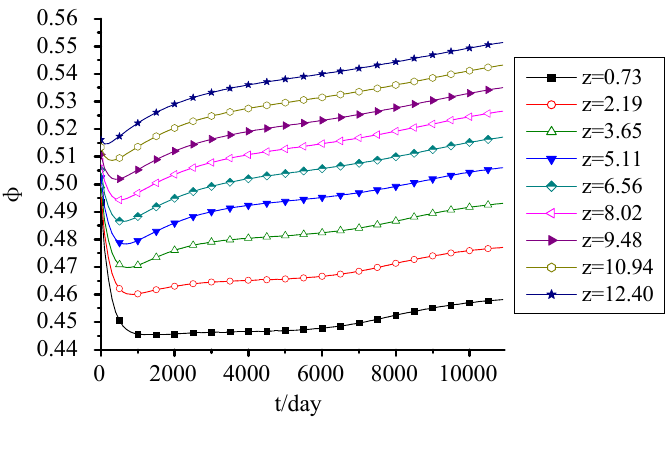
Figure 3. Porosity change with time.